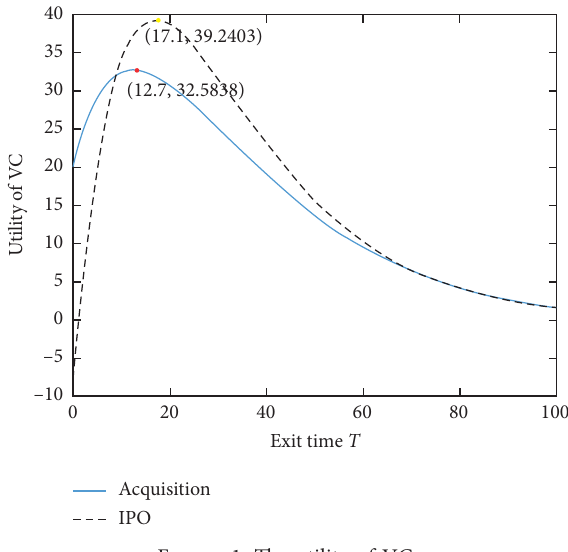
Figure 1: The utility of